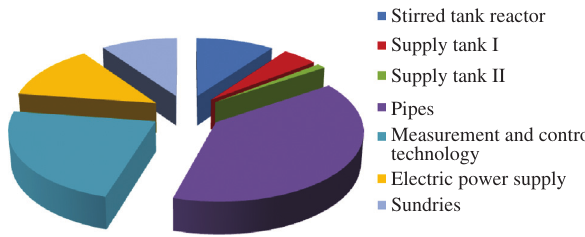
Figure 8 Composition of investment costs for the epoxidized soybean oil (ESBO) pilot plant, best case scenario.